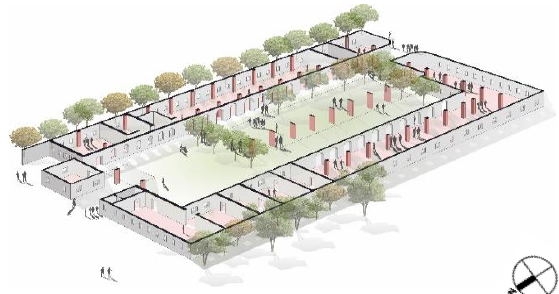
Figure 6 . Project hypothesis - Ex Sapla area